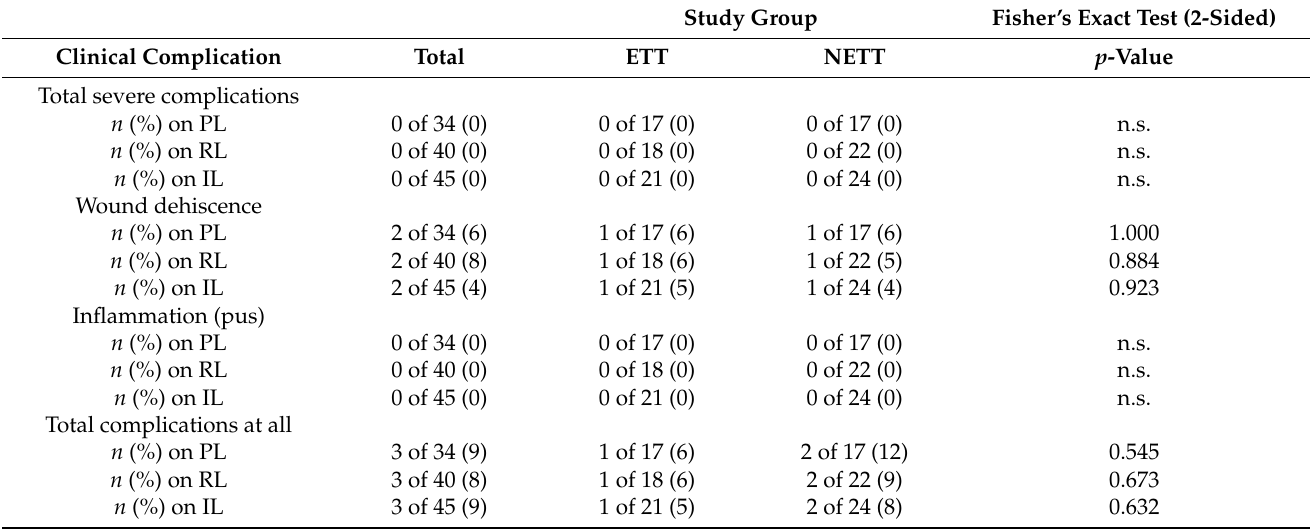
Table 2. Clinical complications at the patient, region, and implant level. Study